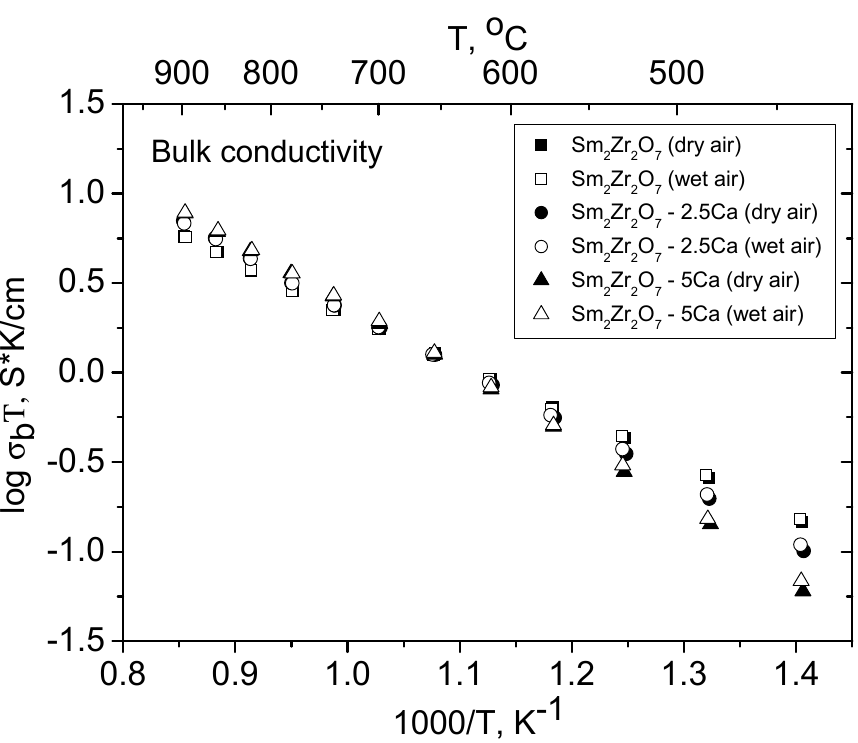
Figure 6. Bulk conductivity of Sm 2 − x Ca x Zr 2 O 7 − x/2 (x = 0, 0.05, 0.1) in dry and wet air.